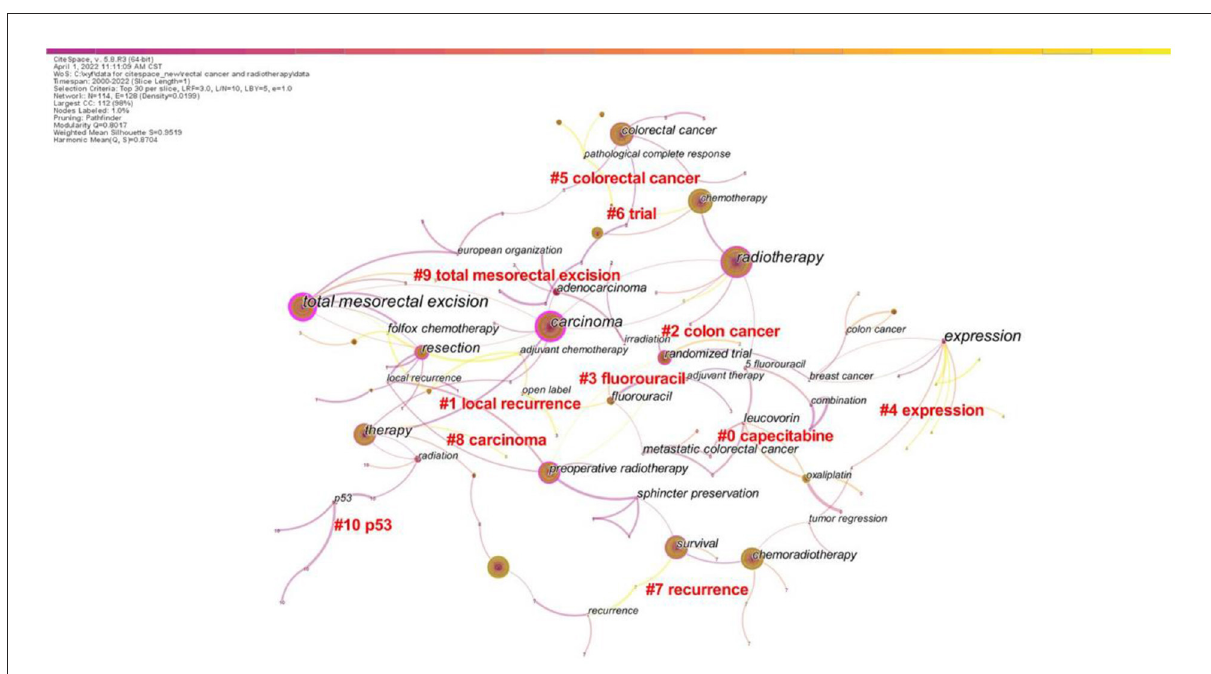
FIGURE7 CiteSpace visualization map of the keyword clustering analysis (Timespan: 2000–2022; Slice Length: 1; Selection Criteria: Top30 per slice; Network: N = 114, E = 128; Density: 0.0199; Largest CC:112; Nodes Labeled:1.0%; Pruning: Pathfinder; Modularity Q:0.8017; Weighted Mean Silhouette S:0.9519).